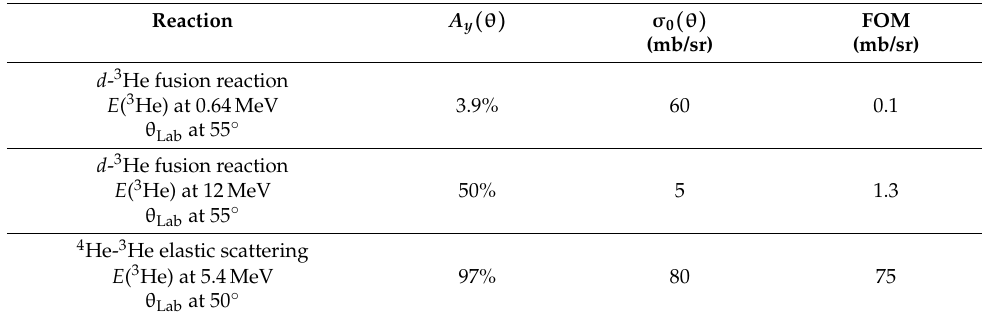
Table 1. Figures of merit (FOM) for 3 He polarimetry.